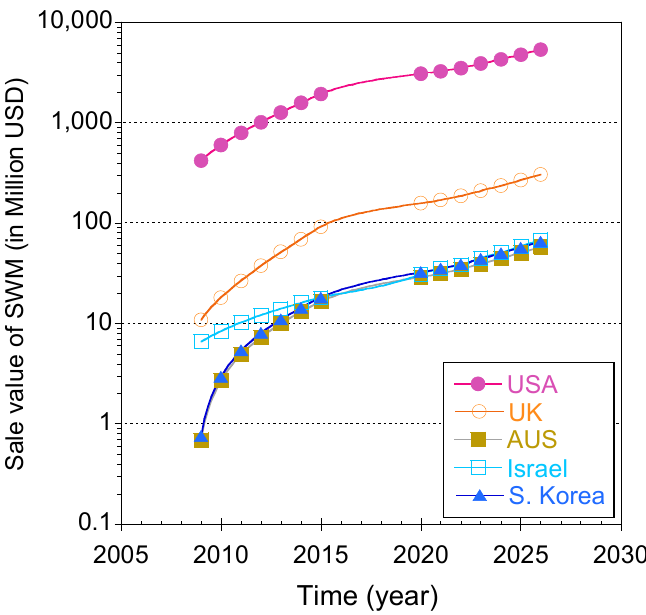
Figure 4. Market status and forecast of sale values (in million USD) of smart water metering with time in the selected countries.